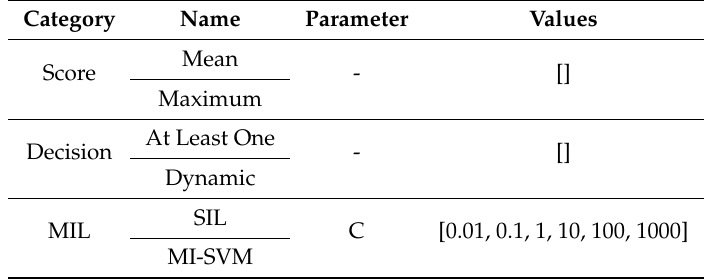
Figure 4. The classification process performed on RCM patients in which the first part of the process remained the same as in Section 2.3. The “Fit Model” and “Prediction” boxes refer to the decision and score level methods discussed in Section 2.4. The testing set was predicted for the patients based on “benign” and “malignant” classes. Table 4. List of all of the classification models and referring evaluated